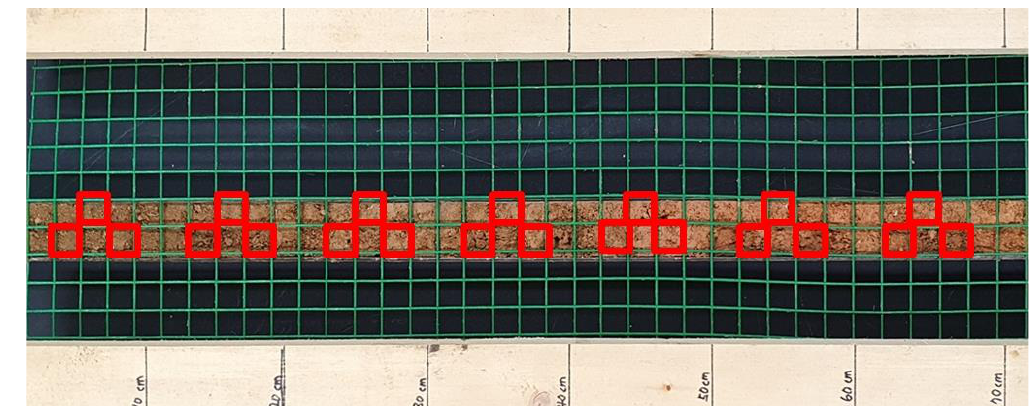
Figure 2. The photograph of the auger with a grid frame on top. The red squares represent the area set for RGB analysis.